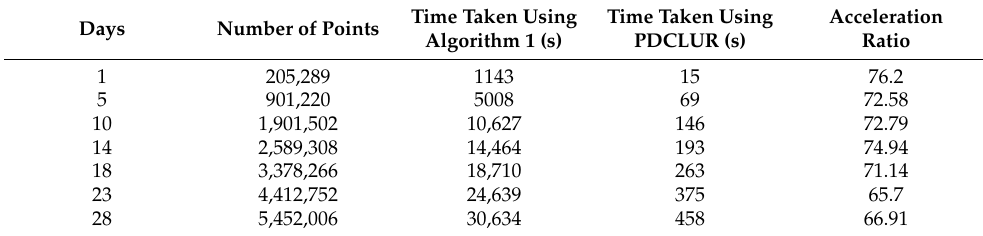
Table 3. Performance difference between PDCLUR and Algorithm 1 during evening